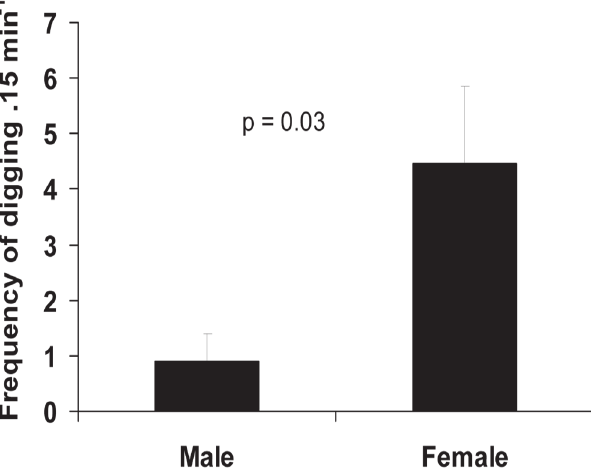
Fig. 2. Mean frequency ( ± SE) of nest digging in the pre- spawning phase by males and females of Laetacara araguaiae (Wilcoxon signed-rank